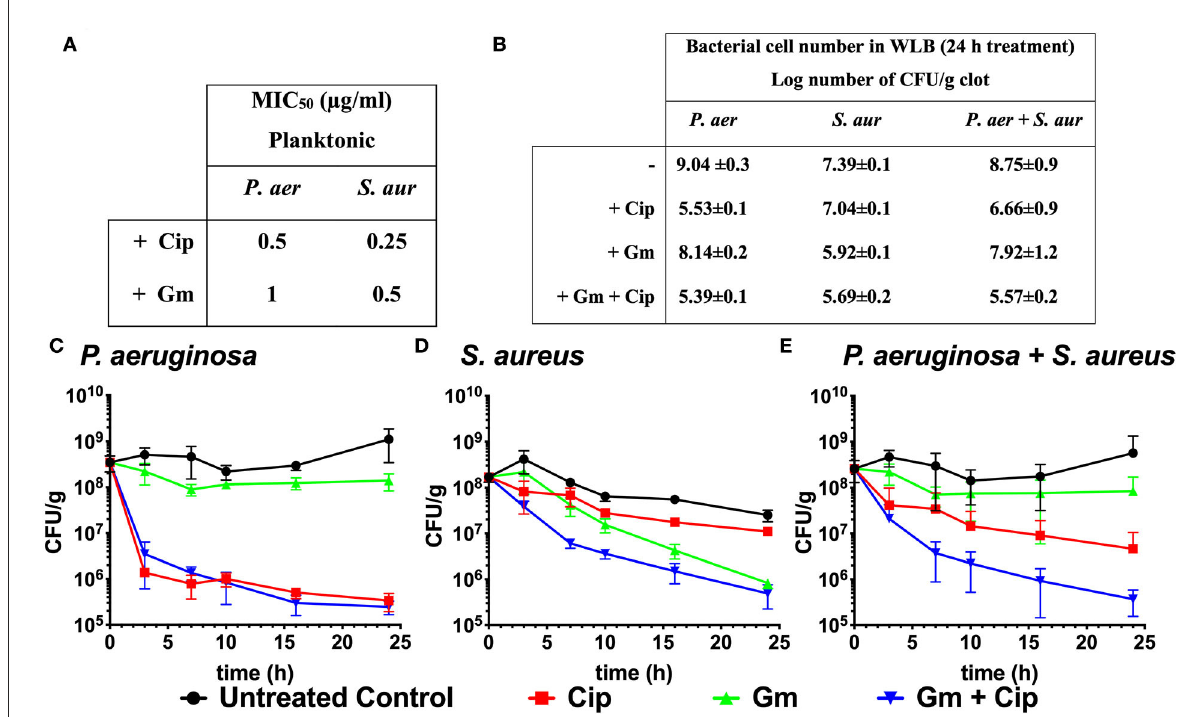
FIGURE1 Bactericidal effect of ciprofloxacin and gentamicin. (A) MIC 50 values of ciprofloxacin (Cip) and gentamicin (Gm) on P. aeruginosa ( P. aer ) and S. aureus ( S. aur ) in planktonic culture. (B) Log number of bacterial cell of P. aeruginosa , S. aureus , and total bacteria comparing treated (with ciprofloxacin and gentamicin at 13.5 µ g/ml) to untreated samples after 24h in a dual-species WLB. (C–E) Bacterial cell number in the clot (CFU/g) measured over 24h without treatment, with ciprofloxacin, gentamicin, and gentamicin + ciprofloxacin at a final concentration of 13.5 µ g/ml. (C) Cell number of P. aeruginosa , (D) S. aureus, and (E) total bacteria ( P. aeruginosa and S. aureus ).